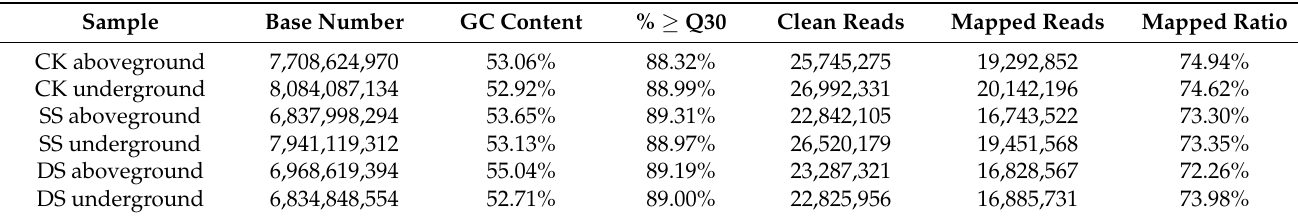
Table 1. Summary of sequencing quality evaluation and assembly statistics in aboveground and underground tissues of bermudagrass under different water regimes for 7